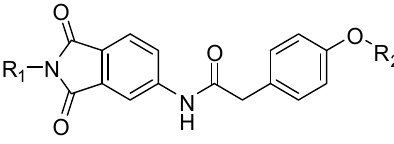
Figure 4. Sites of modification R 1 and R 2 .